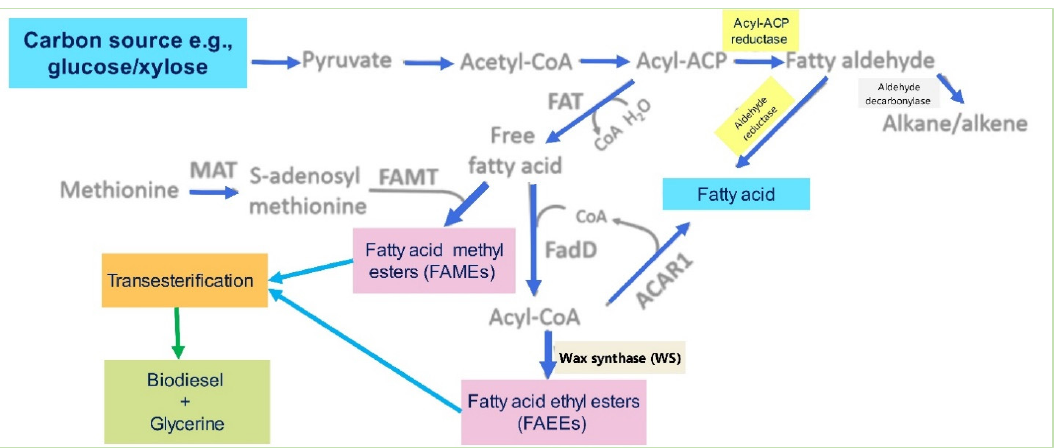
Figure 8. Lipid synthesis pathways to produce biodiesel by E. coli .